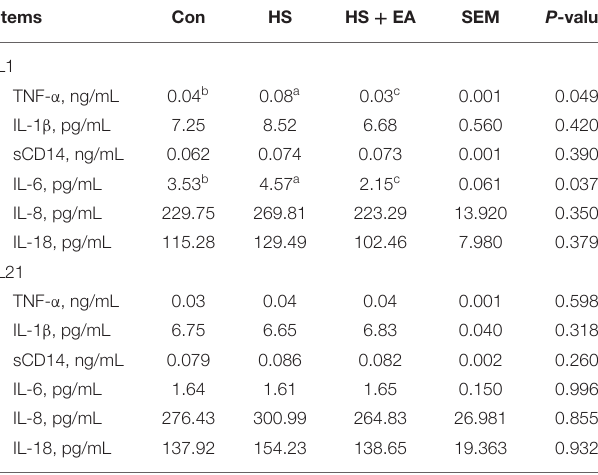
TABLE 6 | Effects of maternal supplementation with EA on the inflammatory cytokine levels in the serum of piglets.